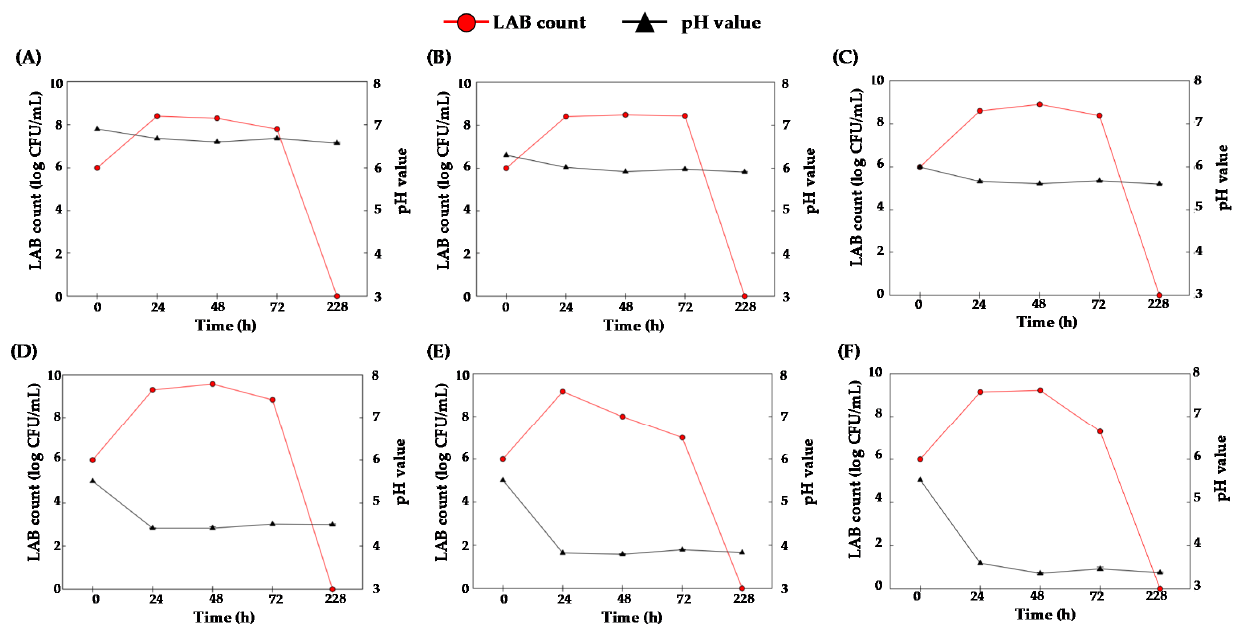
Figure 6. After pretreatment of Porphyra residues (8%) with commercial cellulase at ( A ) 50 U, ( B ) 250 U, ( C ) 500 U, ( D ) 1000 U, and ( E ) 2000 U, the LAB count and pH value of 8% Porphyra residues fermented with KP3 at 37 °C for 0 to 228 h are shown. ( F ) The LAB count and pH value of 8% Porphyra residues pretreated with 2000 U commercial cellulase and fermented with KP4 at 37 °C for 0 to 228 h.